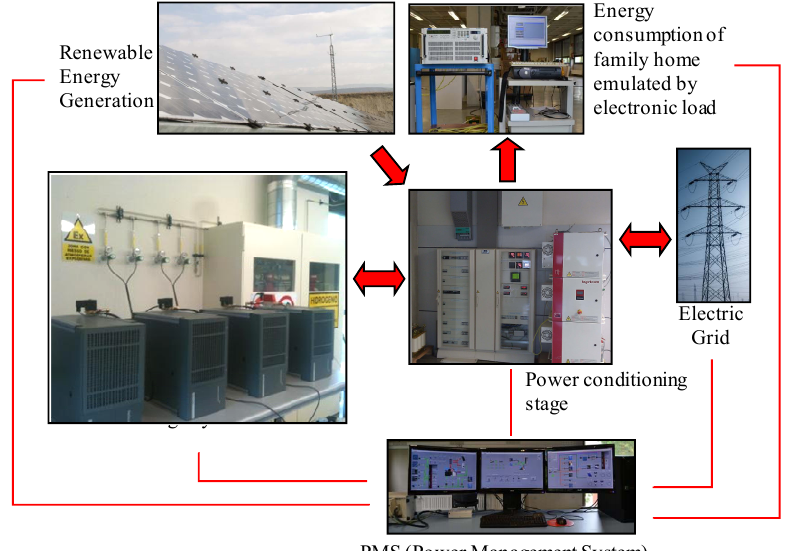
Figure 14. Schematic diagram of the microgrid located at the Public University of Navarre.